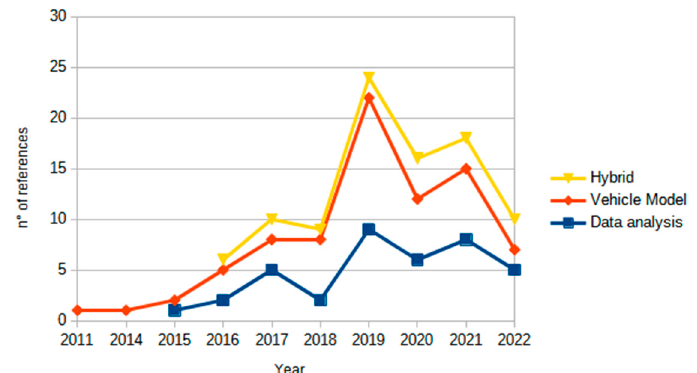
Figure 1. Reviewed references for the content of the paper and chronological trends.